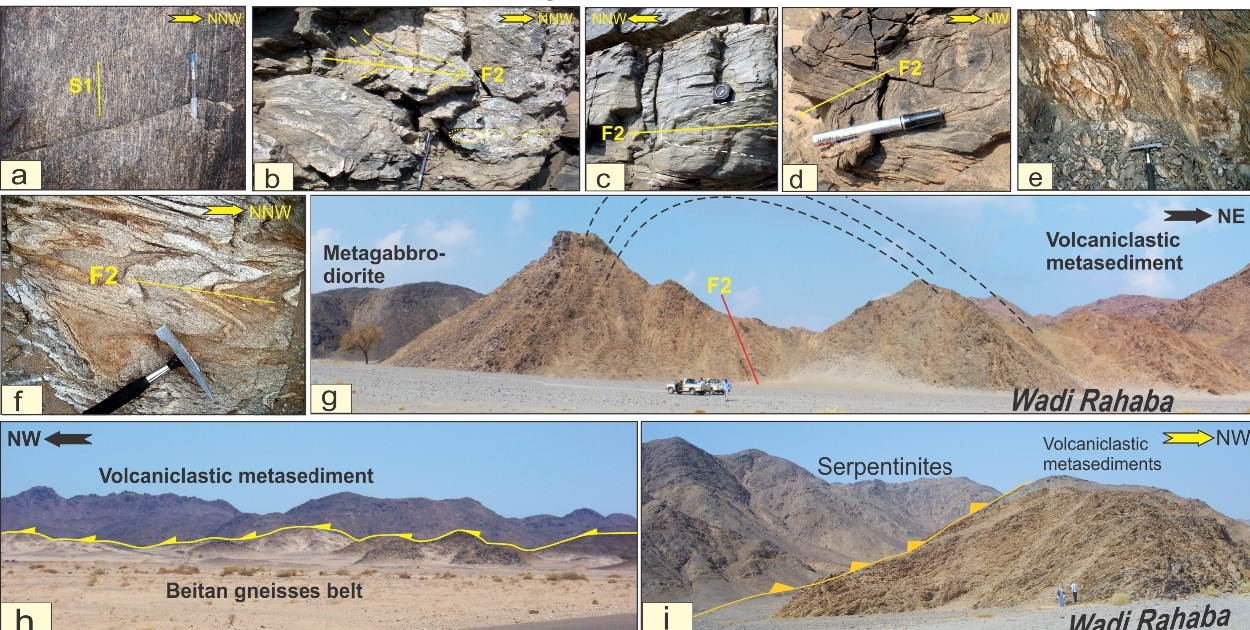
Figure 10. Field photographs of structural elements in the study area: ( a ) gneissosity (S1) in Khuda gneisses defined by the graiN–Shape preferred orientation of quartz–feldspar aggregates, hornblende and biotite; ( b–d ) NNW-plunging, reclined and overturned and recumbent F2 folds and refolded quartz vein in volcaniclastic metasediments of Wadi Rahaba; ( e ) asymmetrical “shearband-type” boudinaged quartz veins in volcaniclastic metasediments around Urga gold occurrence; ( f ) Ptygmatic folds in Beitan gneisses; ( g ) Major F2 asymmteric anticline in volcaniclastic metasediments, Wadi Rahaba; ( h ) SW-verging volcaniclastic metasediments thrust over Beitan gneisses belt, south of Gabal Arais; ( i ) NE-verging serpentinite thrust over volcaniclastic metasediments, Wadi Rahaba.